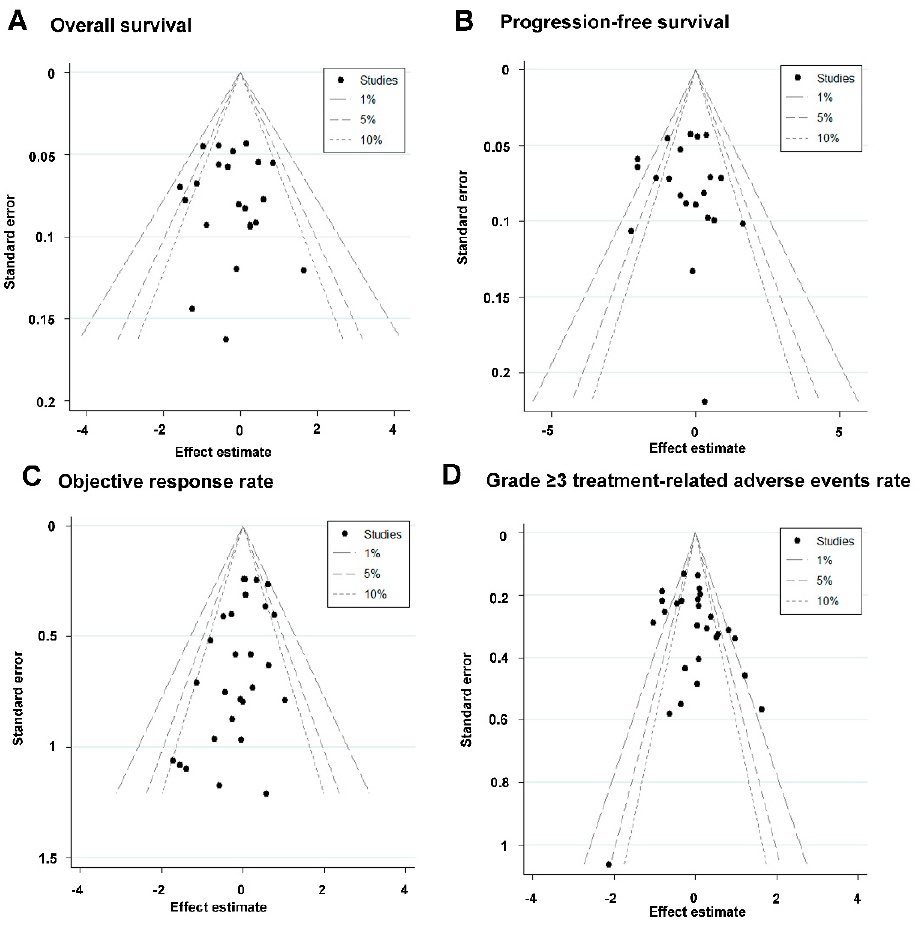
Figure 4. Contour-enhanced funnel plot of ( A ) overall survival (OS), ( B ) progression-free survival (PFS), ( C ) objective response rate (ORR), and ( D ) grade ≥ 3 treatment-related adverse event rates. SOC = standard of care (docetaxel, methotrexate, or cetuximab).